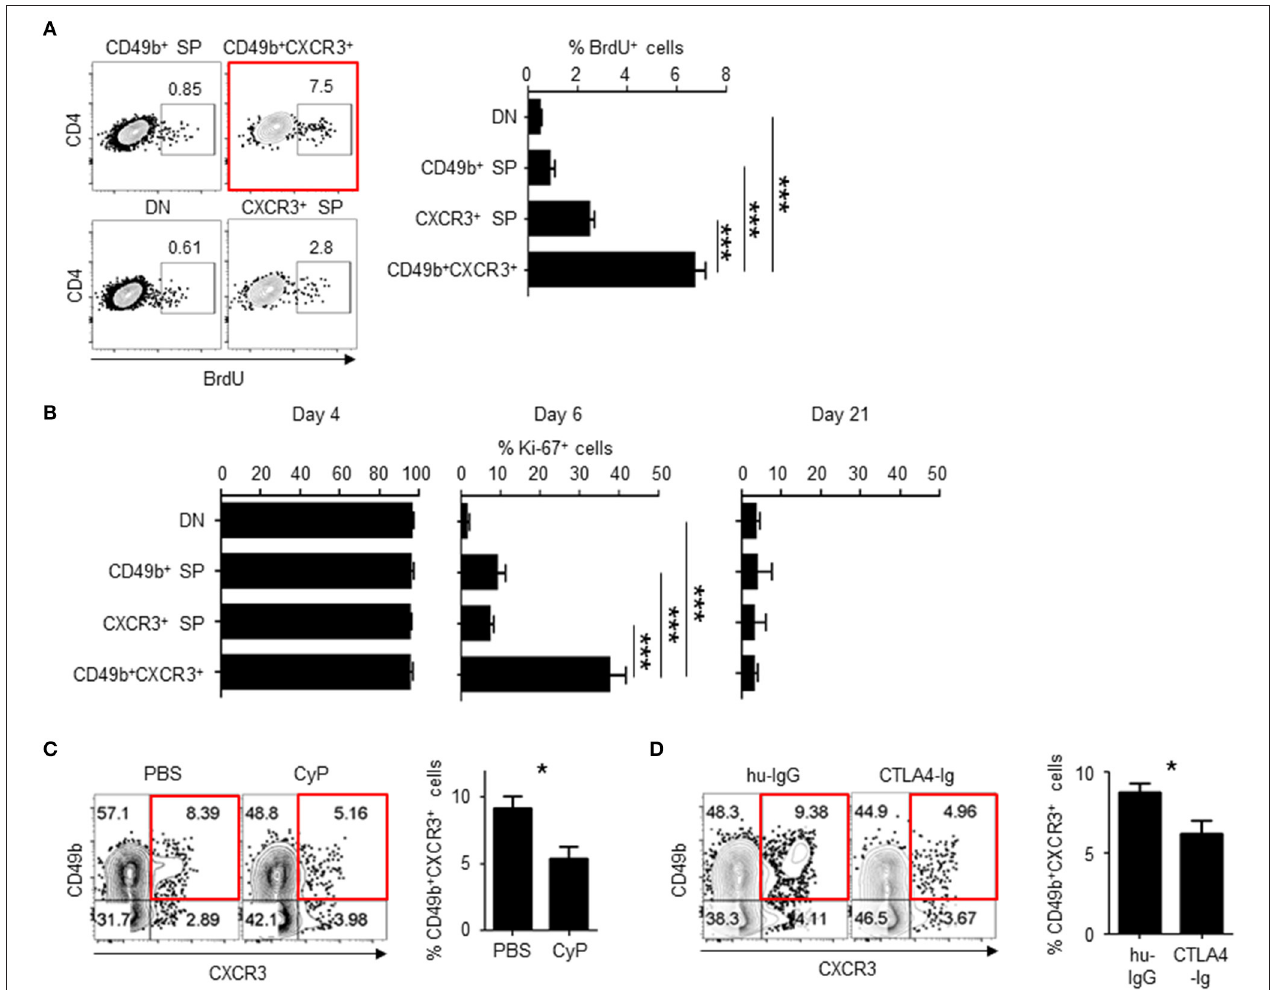
FIGURE 2 | CD49b ± CXCR3 ± memory precursors are highly dividing throughout the primary immune response. C57BL/6 mice were transferred with purified Thy1.1 + LCMV GP-specific CD4T cells, immunized with LCMV-gp61 and LPS and on day 6 after immunization analyzed by flow cytometry and confocal microscopy. (A) More CD49b + CXCR3 + memory precursors incorporated BrdU at the beginning of the contraction phase of a primary immune response. Mice were injected intraperitoneally with 1mg of BrdU on day 5 after immunization. Dot plots show the expression of BrdU in each subpopulation (right) and a bar chart shows the percentage of BrdU + cells in each subpopulation n = 9. (B) Expression of Ki-67 in each subpopulation of activated CD4T cells. A bar chart represents the percentages of Ki-67 + cells in splenic subpopulations defined by the expression of CD49b and CXCR3 on days 4, 6, and 21 after immunization n = 7. (C) Injection of CyP reduces numbers of BM memory precursors. Mice were injected intravenously with 50 mg/kg CyP or PBS on day 5 after immunization. Dot plots show the expression of CD49b and CXCR3 within splenic Thy1.1 + CD44 hi CD4 + B220 − NK1.1 − PI − cells of CyP- or PBS-treated mice. A bar chart displays the percentages of the CD49b + CXCR3 + subpopulation n = 11. (D) CTLA-4 Ig reduces numbers of BM memory precursors. Mice were injected intraperitoneally with 200 µ g CTLA-4 Ig or human IgG on days 4 and 5 after immunization n = 12. These data are representative of two or more independent experiments. Data are shown as mean ± SD. * p < 0.05, *** p <